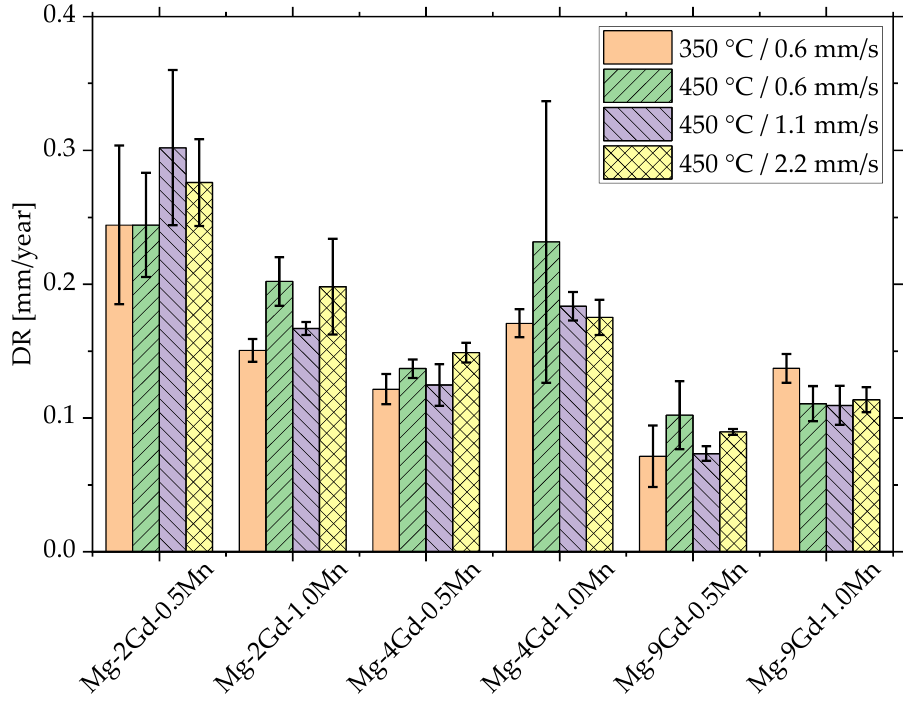
Figure 8. Degradation rates (DR) based on weight loss after 7 d immersion for Mg – Gd-0.5Mn Mg – Gd-1.0Mn. Values for Mg – Gd are shown as reference. Error bars are standard deviation. Degradation rates of Mg – Gd are shown as reference. Error bars are standard deviations.